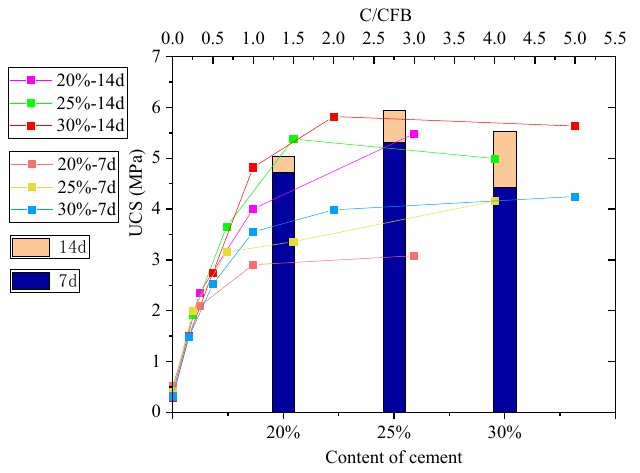
Figure 6. UCS curve of cement-stabilised soil admixed with CFB-BA for 7 days and 14 days (bar graph shows strength of cement-stabilised soil).